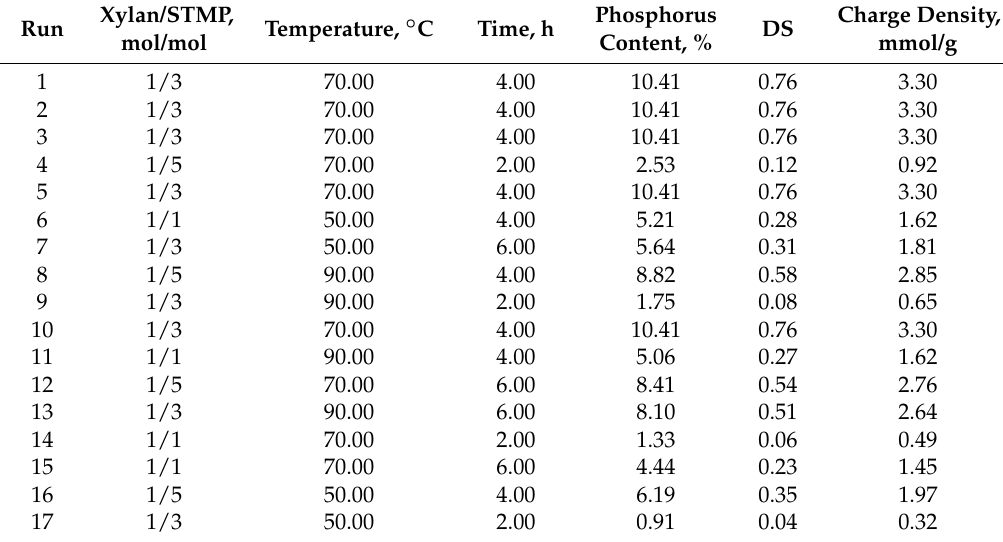
Table 1. The parameters and outcomes of phosphorylation of